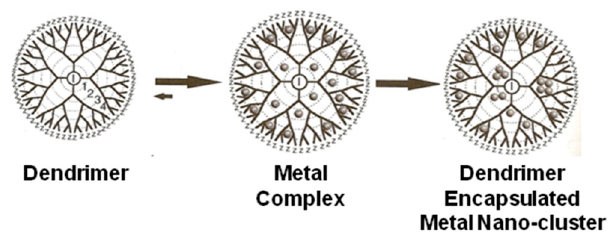
Figure 11. Use of PAMAM dendrimers as ligand functionalized templates for the complexation of metal salts and subsequent reduction to zero-valent metal nanoclusters. Reprinted with permission from [35]. Copyright 1998 American Chemical Society.